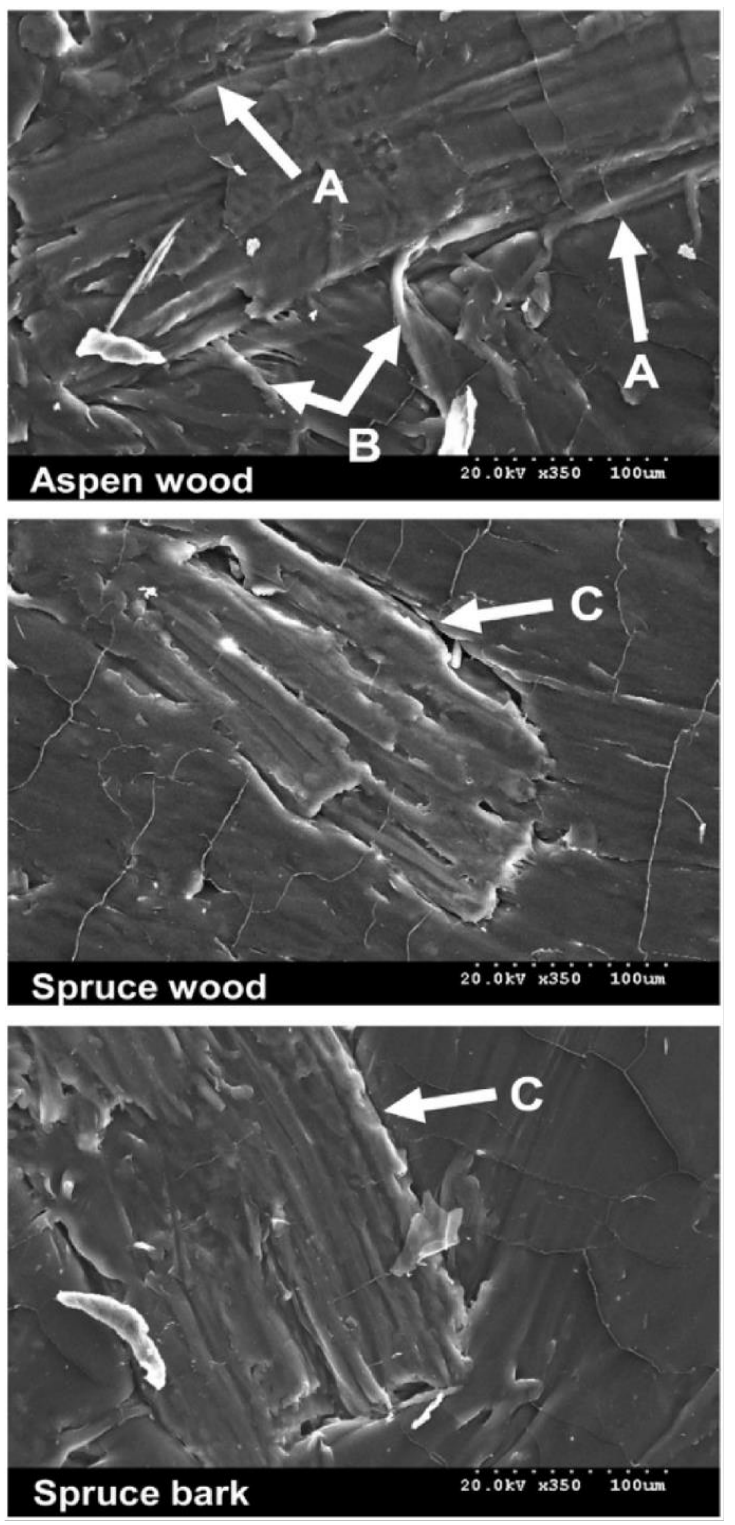
Figure 4. SEM images of aspen wood, spruce bark, and spruce wood fibres: (A) close contact/good wetting, (B) macro-fibrils, and (C) no close contact [57] (reprinted with permission from Elsevier, Licence Number: 5446961305021).